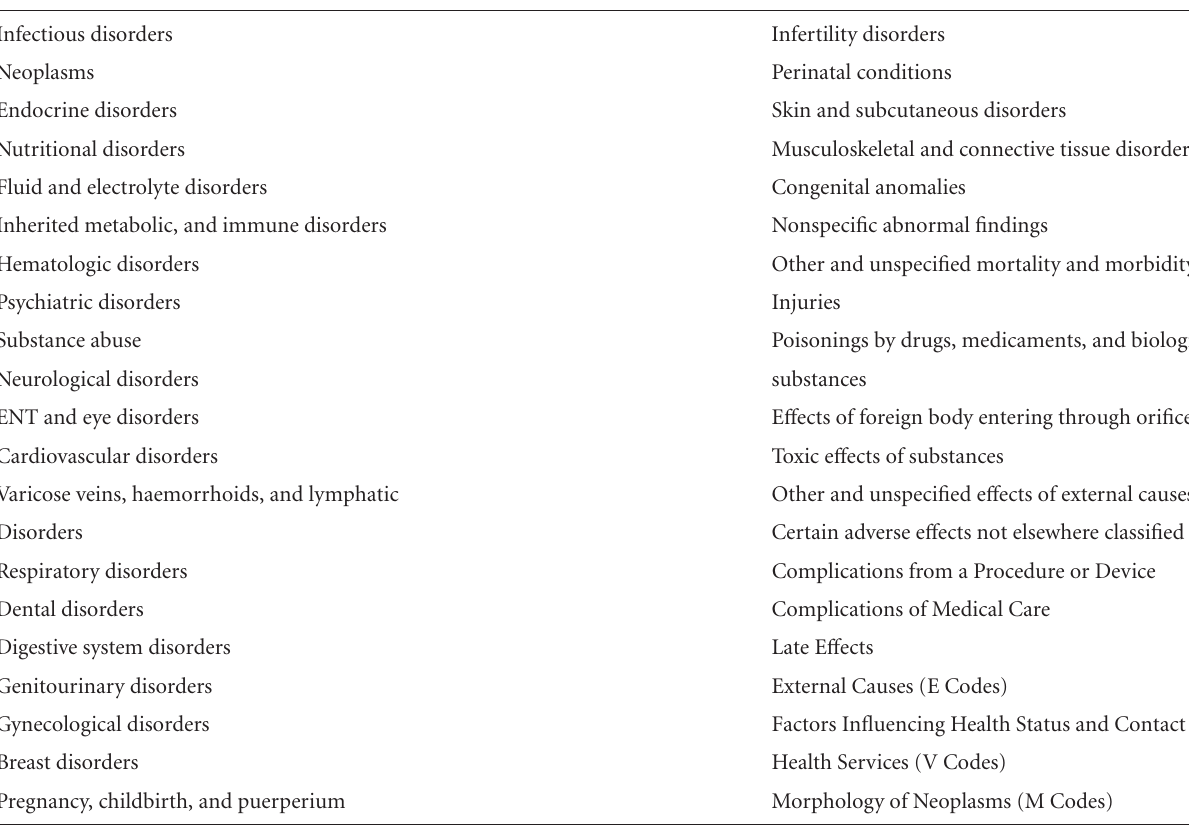
Table 1: Categories created by the